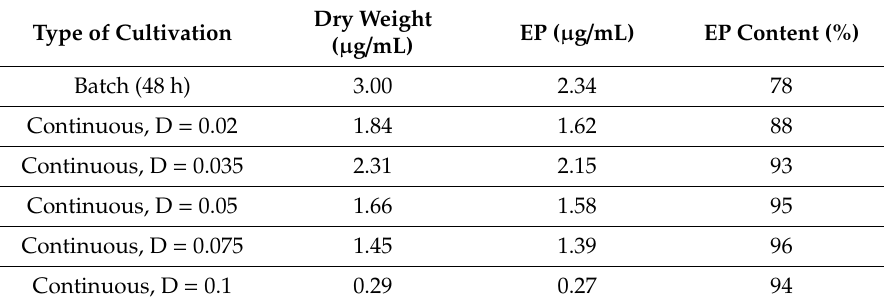
Table 2. EP content in ethanol pellet after batch and continuous